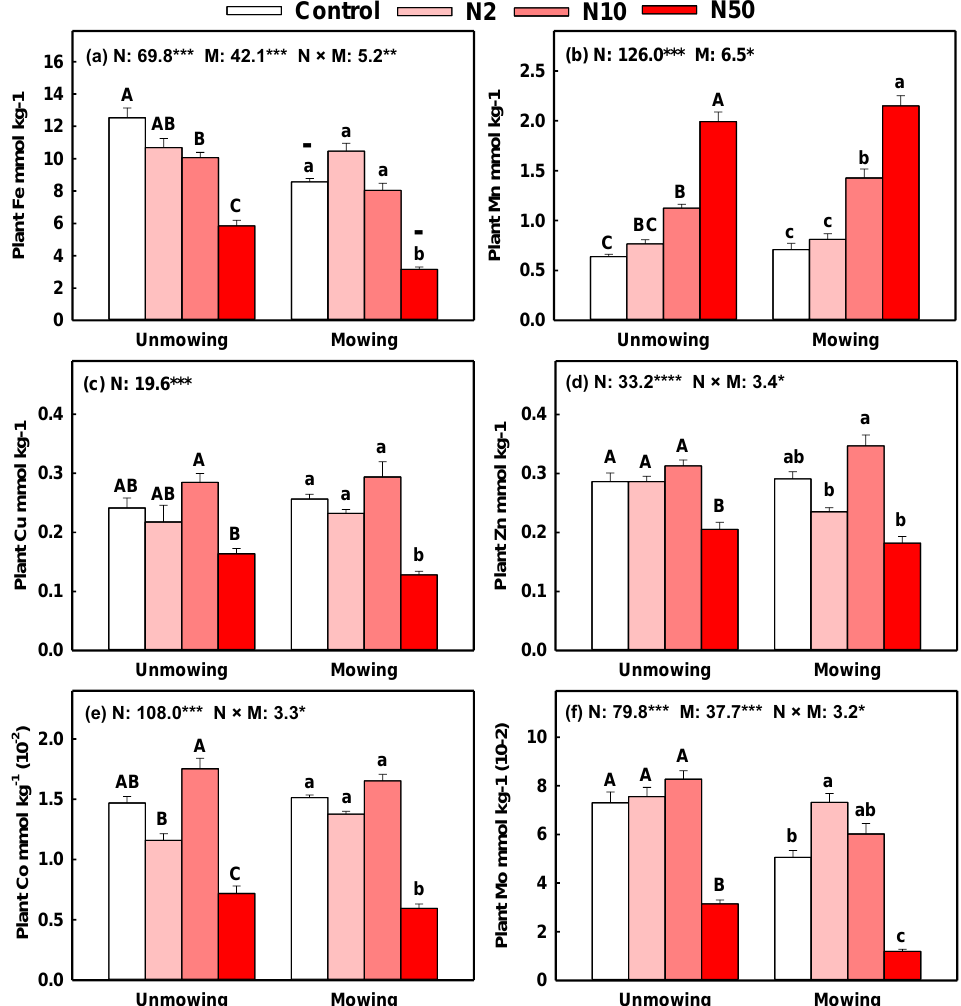
Figure 2. Effects of N addition on the contents of six micronutrients (Fe, Mn, Cu, Zn, Co, and Mo) with unmowing and mowing treatments in aboveground plant parts. Note: Data are presented as means ± standard error. The results of two-way ANOVA (F values) are shown at the top of each figure. *, **, *** indicates significant differences at p < 0.05, 0.01, 0.001, respectively. Different uppercase or lowercase letters denote significant differences ( p < 0.05) between control and N addition plots with unmowing and mowing treatments. Symbols +, − indicate significant positive or negative effects of mowing compared with their counterparts with the same N addition rate at p < 0.05. Only items with significant cases were shown.